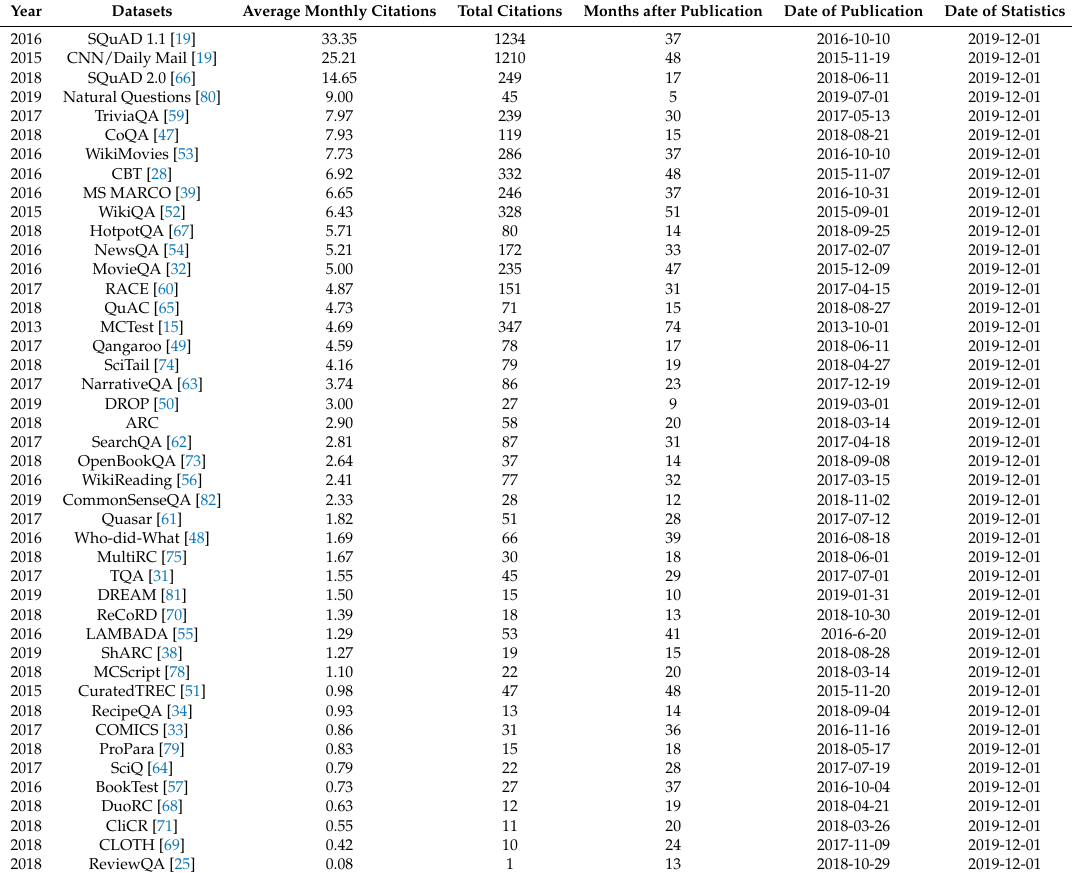
Table 9. Citation analysis of the paper in which each dataset was